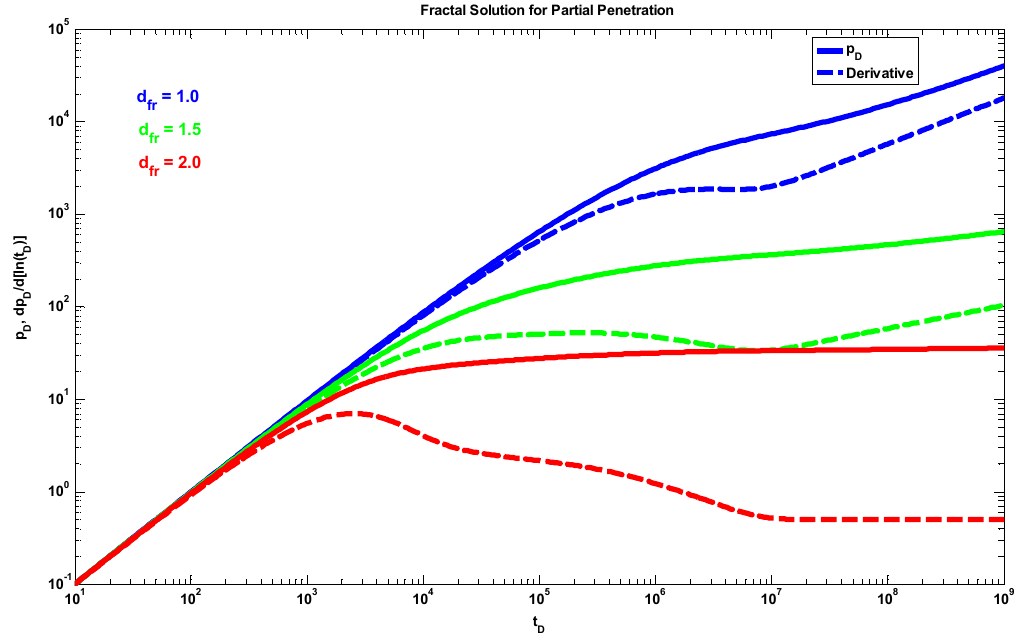
Figure 6. Fractal case: z wD = 0.4, h D = 10,000, h pD = 0.2, S = 0, C D = 100, ε = 1, d fz = 1, θ z = 0.